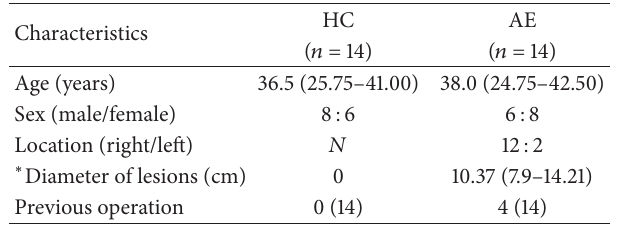
Table 2: Basic clinical characteristics of patients with hepatic alveolar echinococcosis.